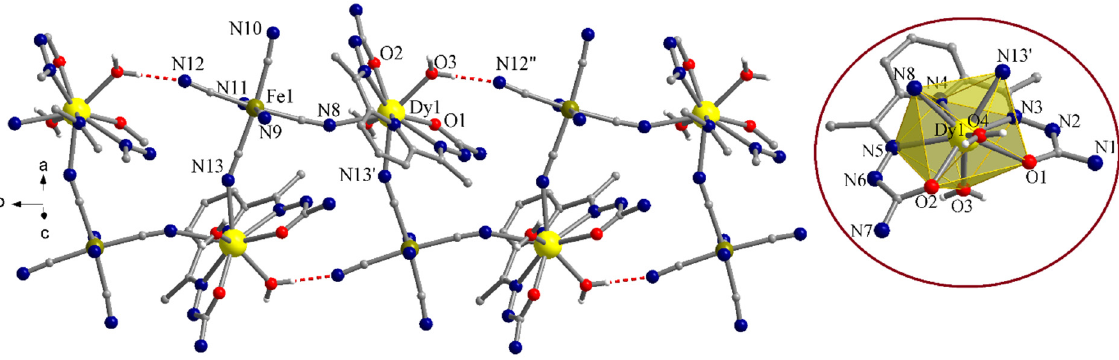
Figure 4. Perspective view of the 1D coordination polymer in compound 2 DyFe . The inset shows a detail of the coordination environment of the Dy III ion (symmetry codes: ’ = 1 − x, − 0.5 + y, 1.5 − z; ” = x, − 1 + y, z).